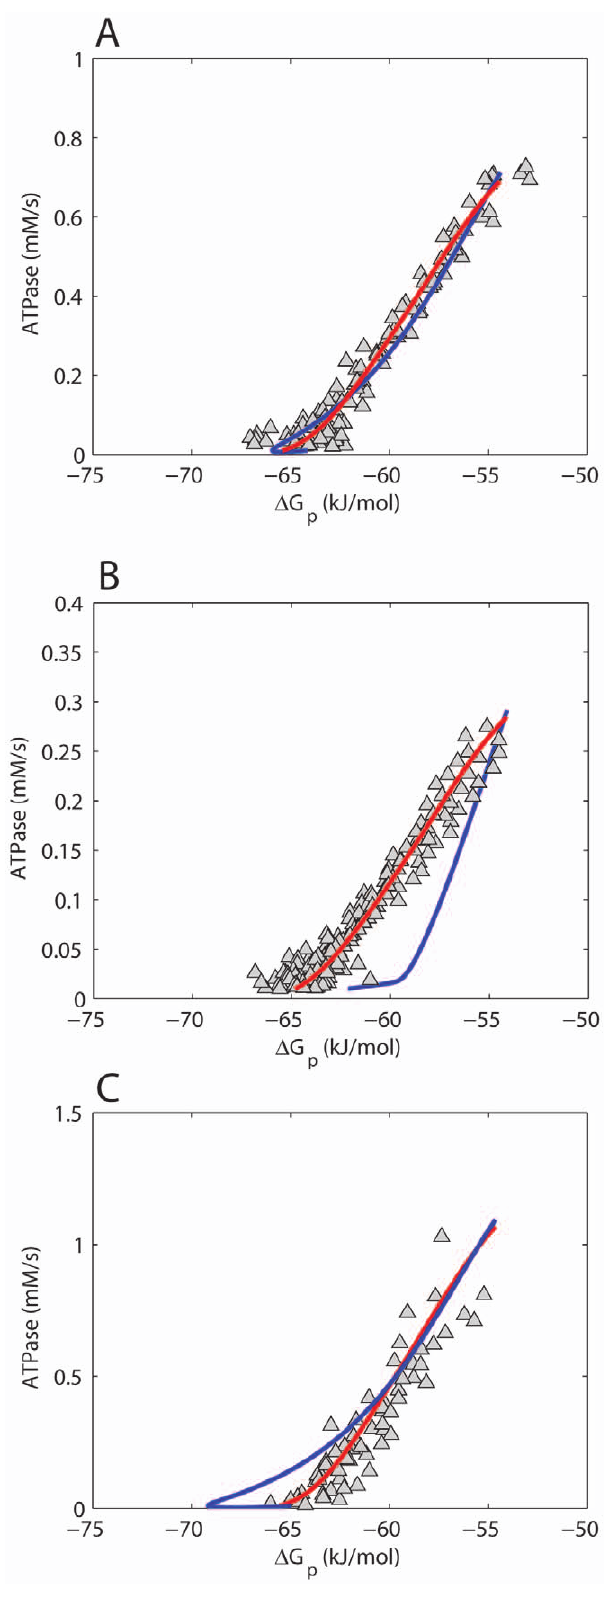
Figure 5. Model predictions for phenotypes with different mitochondrial densities. Model predictions of the n G p - J p relation during post exercise recovery. Results are shown for normally active healthy subjects ( A ), sedentary subjects ( B ), athletes ( C ). Experimental